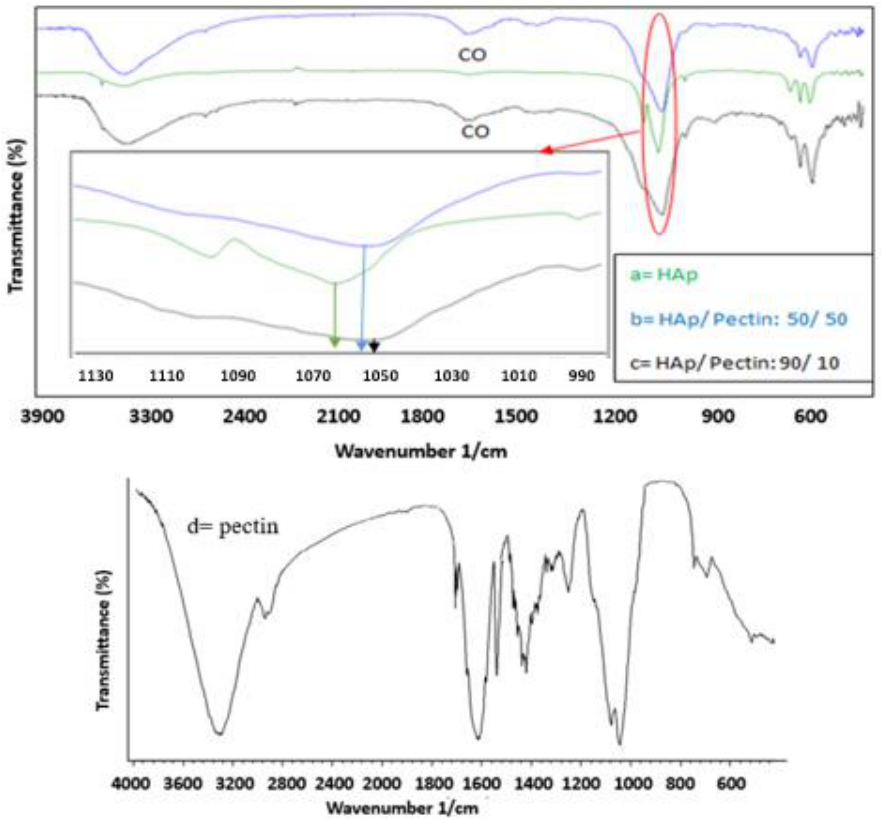
Figure 2. FT-IR spectra of the synthesized HAp nanoparticles in the presence and absence of various pectin concentrations, with molar ratios of 100/0 (a), 50/50 (b), 90/10 (c), and pectin (d) extracted from the prickly pear cladodes.